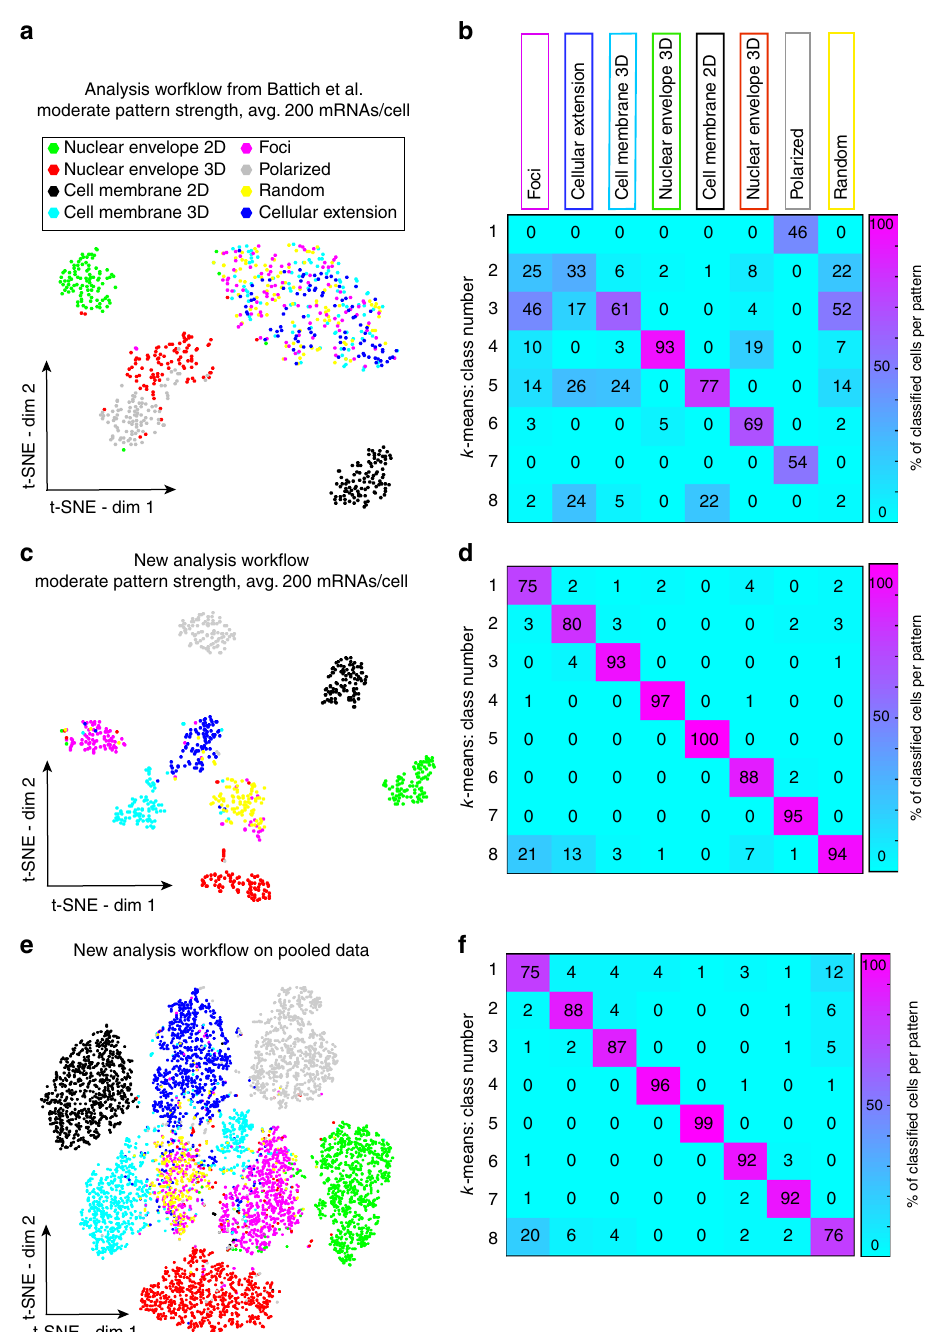
Fig. 2 Analysis of simulated data. a Analysis with previously published mRNA detection approach and localization features. In the t-SNE plot, each dot is a cell colored with its localization pattern. b Confusion matrix for k-means clustering with 8 classes for data in a . Rows show identi fi ed classes, columns the known localization pattern. Numbers in each square indicate percentage of cells for a localization pattern (column) that was assigned to a given class (row). Off-diagonal elements are mis-classi fi cations. c , d t-SNE projection and confusion matrix as in a and b but determined with our 3D spot detection with GMM and the new localization features. e Analysis of pooled simulated data (different pattern strength and expression levels). Analysis and t-SNE projection as in c . f Confusion matrix for data in e with k-means clustering performed on t-SNE projected data in six